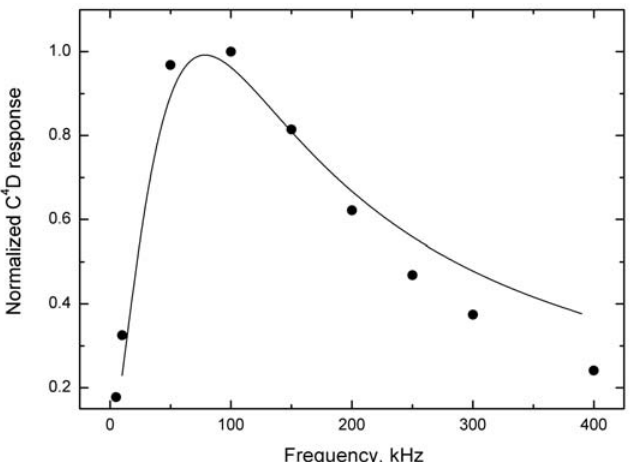
Figure 8. The model (solid line) and experimental (points) dependences of the insulated wire cell response on the input voltage frequency; electrodes placed at right angles to the = 4.5 × 10 − 5 m, test liquid flow, Figure 2D (1). The modeling parameters are: r 1 = 5 × 10 − 5 m (difference r − r is the dielectric thickness), w = 2.54 × 10 − 4 m (the r 2 2 1 = 4 electrode length equals the internal diameter of the PTFE tubing), d = 4 × 10 − 4 m, ε r = 7.5 × 10 − 5 S m − 1 (5 × 10 − 6 M (polyimide insulating film), carrier liquid conductance κ E = 1.5 × 10 − 3 S m − 1 (10 − 4 M KCl) and the KCl), analyte zone conductance κ A